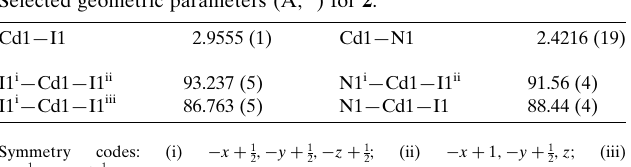
Table 2 Selected geometric parameters (A˚ , (cid:4) ) for 2 .